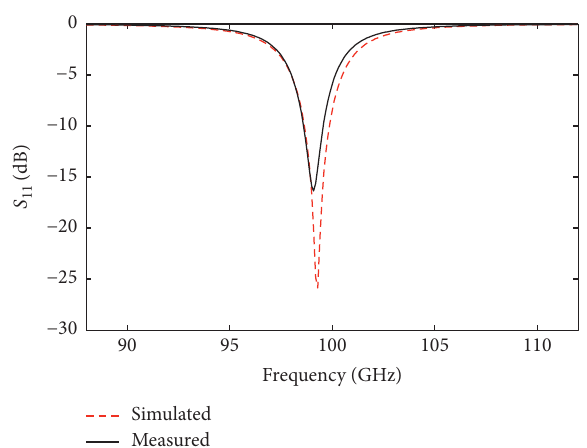
Figure 16: Simulated and measured S antenna.